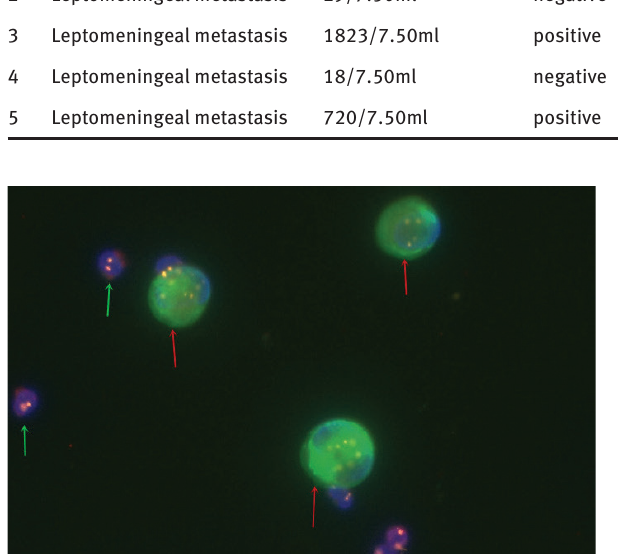
Figure 1: Circulating tumor cells (CTCs) ( red arrow): positive DAPI staining (blue fluorescence), highly expressed PAN- CK (green fluo- rescence), CEP8 (polyploidy) , and CD45 (absent expression); white cells (green arrow) ： positive DAPI staining (blue fluorescence) , PAN-CK (absent expression) ， CEP8 (diploid) ， and CD45 (red fluore- scence). ×400